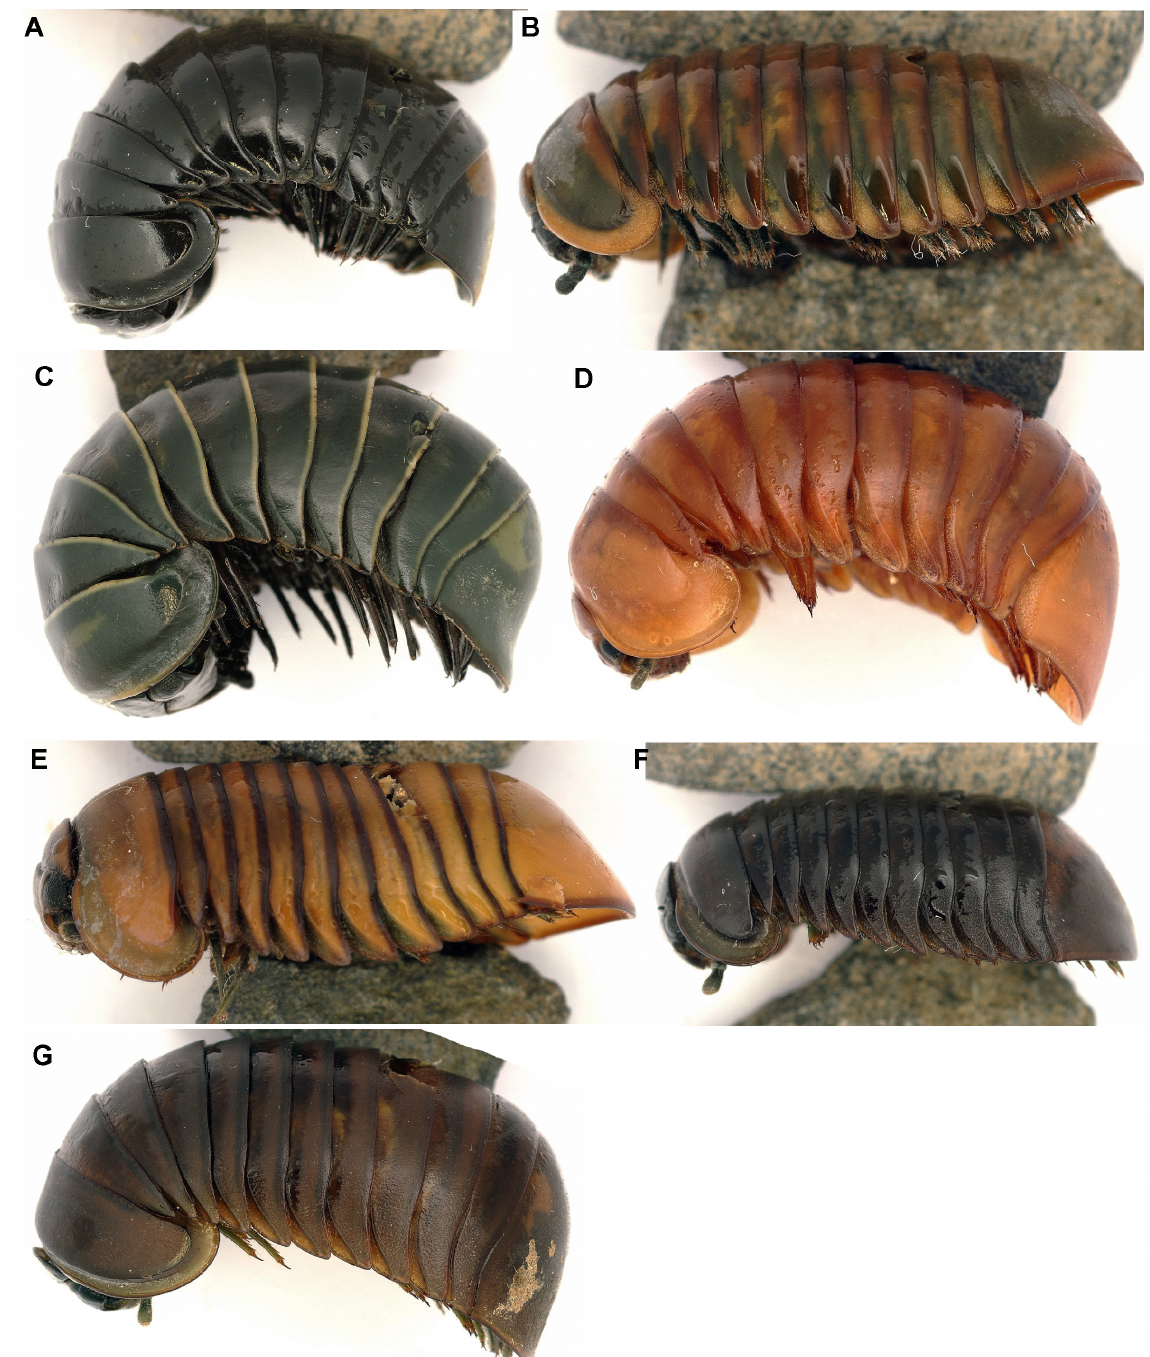
Fig. 2. Habitus photographs of the seven new species of Zoosphaerium , lateral view. A . Zoosphaerium nigrum sp. nov., holotype (CASENT 9068289). B . Z. silens sp. nov., holotype (FMNH-INS 3119887). C . Z. ambatovaky sp. nov., holotype (CASENT 9068294/1). D . Z. beanka sp. nov., holotype (FMNH-INS 3119897). E . Z. voahangy sp. nov., holotype (FMNH-INS 3119921). F . Z. masoala sp. nov., holotype (FMNH-INS 3195651). G . Z. spinopiligerum sp. nov., holotype (FMNH-INS 3119885). Not to